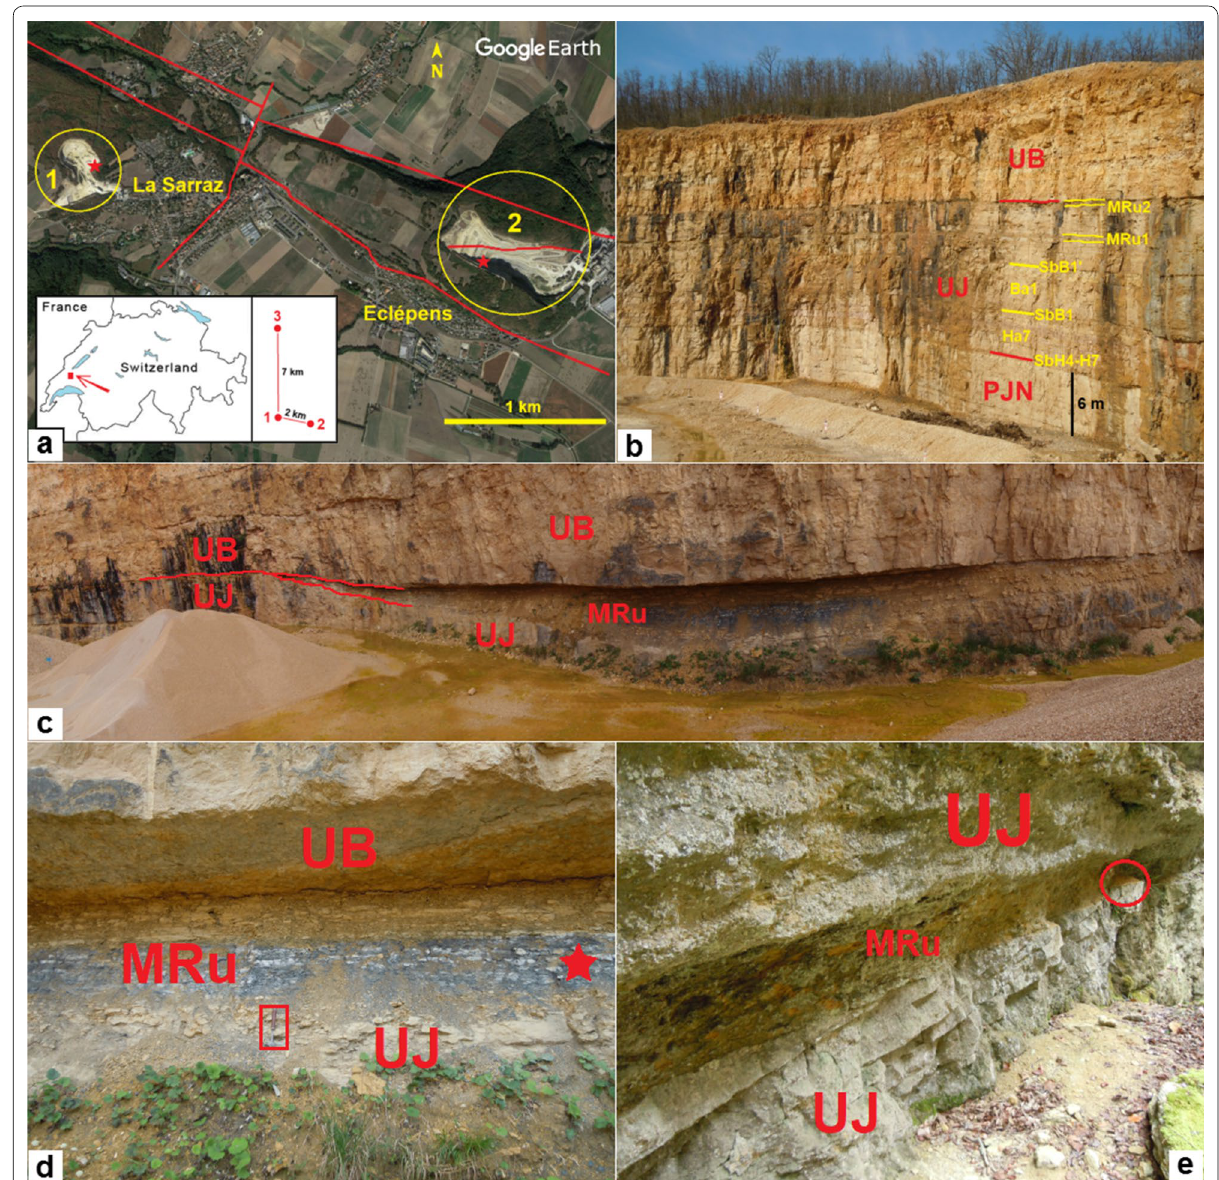
Fig. 1 a Location maps with aerial view (Google Earth, Copernicus Sentinel data 2018 / NPOC) in the Vaud Jura Mountains (W‑Switzerland), red square indicated by red arrow study area, yellow circle 1/red spot 1 Les Buis quarry near La Sarraz, yellow circle 2/red spot 2 Eclépens quarry of the Mormont = = = Hill, red spot 3 Montcherand section in the Gorges de l’Orbe, red stars studied sections, network of red lines the Mormont—La Sarraz fault system = = = reported from the geological map of Switzerland 1:25 ′ 000. b La Sarraz–Les Buis quarry (8/3/2020), northern part of the quarry, UB Urgonien Blanc, = MRu1‑2 Marnes de la Russille (layers 1 and 2), UJ Urgonien Jaune, PJN Pierre jaune de Neuchâtel, Ha7‑Ba1 basal Early Barremian sequences with = = = = sequence boundaries SbH4‑H7, SbB1 and SbB1 ′ (cf. Fig. 3). c , d La Sarraz–Les Buis quarry, southern part of the quarry, channelized and very fine‑grained Marnes de la Russille ( c : 7/6/2014; d : 17/8/2014, hammer in red frame 31.5 cm long, red star late Early Barremian LSBMRu1 sample with nannoflora = = of NC5D/LK19 biozones reported in this study). e Upper part of the Montcherand section along the Orbe river (23/11/2014), truncated and bevelled layer of basal shallow marine Marnes de la Russille above transgressive inclined foresets of large ripples, red circle diameter 31.5 cm (small ammonite = Pseudometahoplites sp. juv. was found in the mound of yellow marls on top inside). Captions: UB Urgonien Blanc, MRu Marnes de la Russille, = = UJ Urgonien Jaune. f – g La Sarraz–Les Buis quarry (8/3/2020), northern part of the quarry and detail of Fig. 1b, h (right parts), TST Transgressive system = = track with reddish ripples of the sequence Ha7, HST Highstand system tracks marked by two thick whitish coarse beds forming the top of sequences = Ha7 and Ba1, respectively, Ba1 ′ ‑Ba2‑Ba3 late Early‑to‑early Late Barremian sequences with sequence boundaries SbB1 ′ , SbB2 and SbB3 (cf. Fig. 3). h – i La = Sarraz–Les Buis quarry (23/2/2020), northern part of the quarry ( h ) and detail of NW cliff (red square, i ) with transverse cross sections of two small proximal MRu1‑2 channels (yellow ellipses) forming the distal larger channel (Figs. 1c, d and 3) about 20 m below and 250 m laterally at the base of the opposite SE cliff. j Rare and well‑preserved Alcyonarian corals from the uppermost massive UJ limestones (early Late Barremian) of the Eclépens